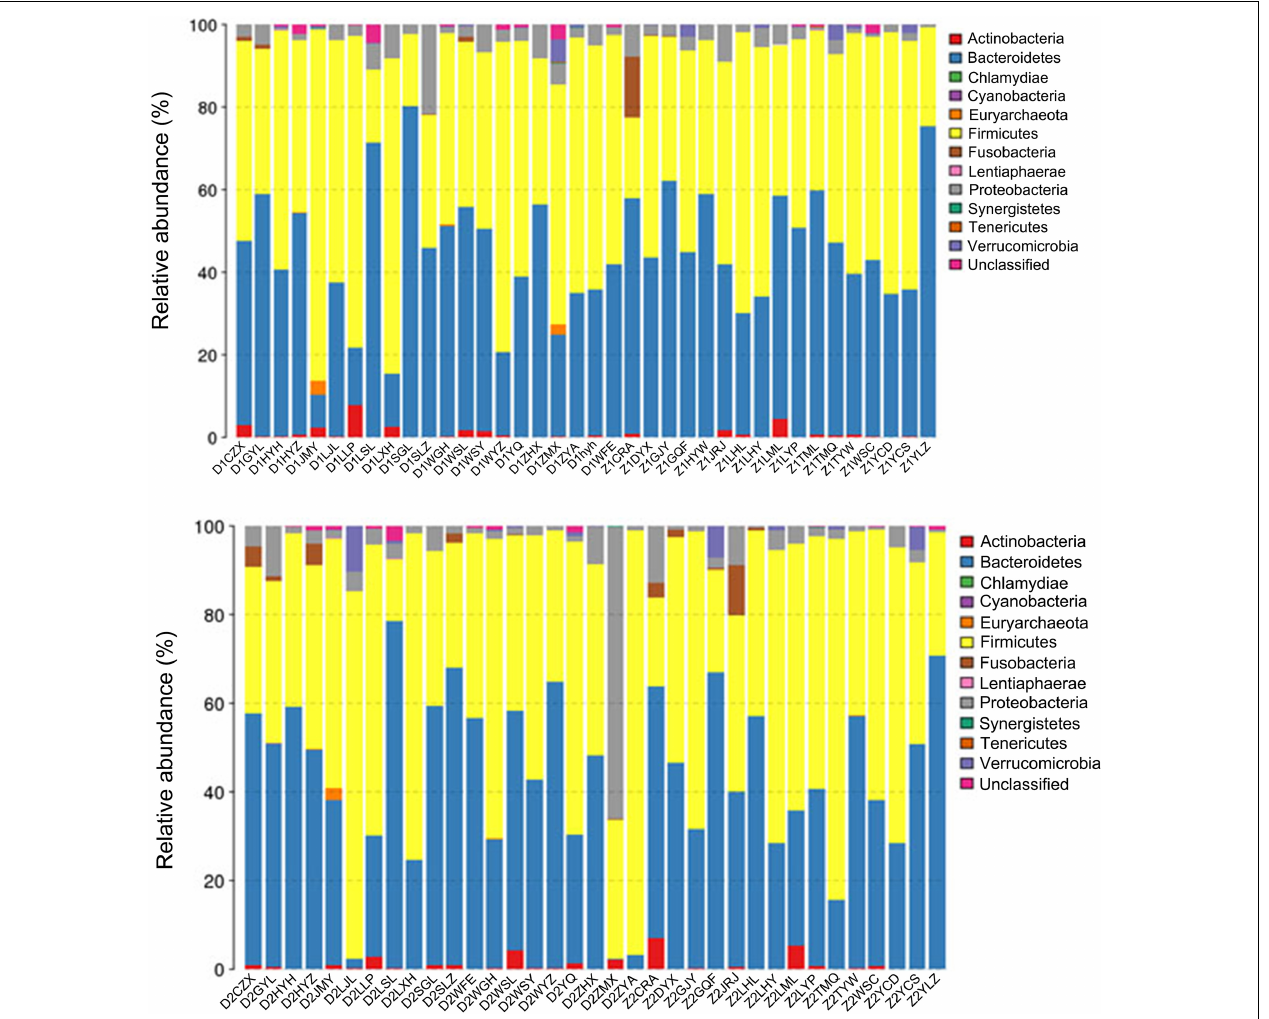
FIGURE 4 | Phylum-level changes of intestinal flora in the patients in the Electroacupuncture group and the Control group (Z1, the Electroacupuncture group before treatment; Z2, the Electroacupuncture group after treatment; D1, the Control group before treatment; D2, the Control group after treatment).